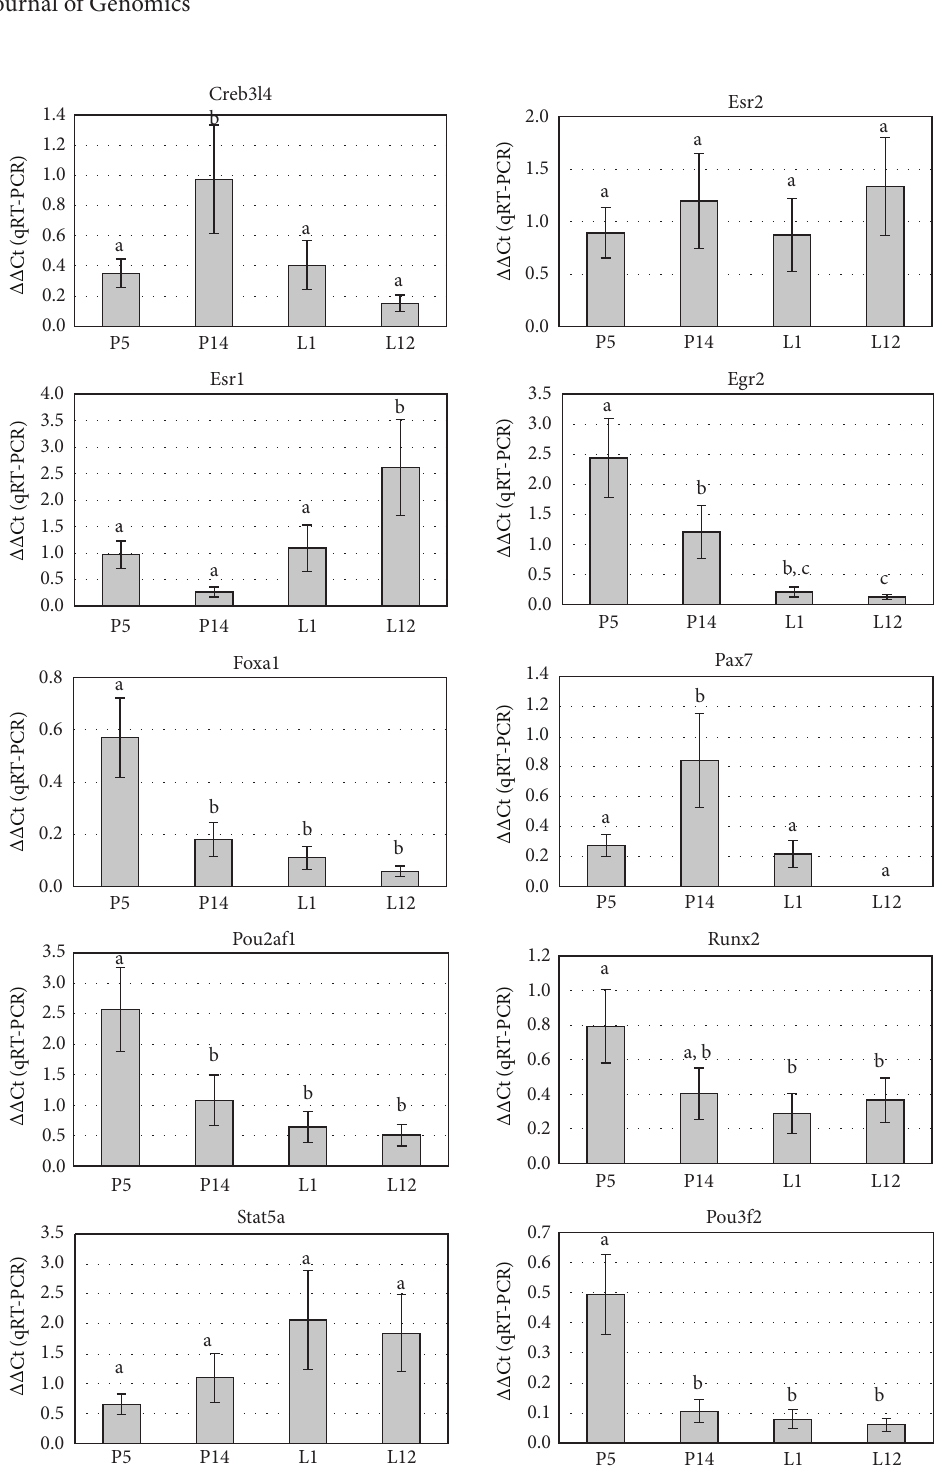
Figure 6: Gene expression profiles of the putative transcriptional factors identified by microarray using qRT-PCR. Quantitative real time- PCR was performed as in Experimental Procedures , and the calculated mean log ratio for each gene in their corresponding developmental stage was determined. A positive value indicates a greater mRNA abundance in a developmental stage than in the control group, whereas a negative value indicates a lower mRNA abundance in a developmental stage than in the control group. Bars represent data obtained by qRT- PCR ( y -axis), whereas the x -axis represents the physiological time point. The average fold change relative to time-matched virgin controls for three animals per group is shown. Genes are indicated by their official gene symbols. Data are presented as the mean of three independent experiments, each performed in triplicate. Bars represent the average ( ± SD) fold change. Different letters indicate statistically significant differences between developmental stages ( 𝑃 < 0.05 ). Note that the scales of the y -axis vary among genes. ND: not